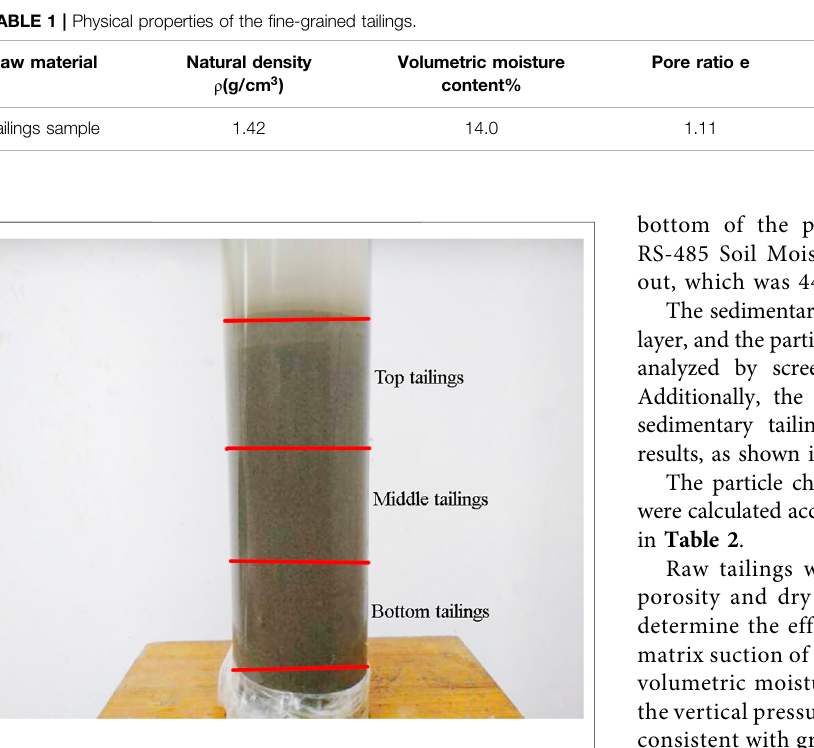
FIGURE 1 | Physical model of fi ne-grained tailings sedimentation.